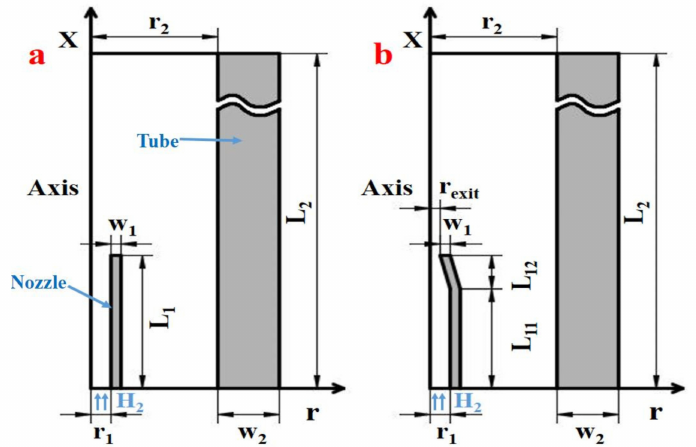
Figure 1. The schematic diagrams of physical models: ( a ) d = 0.8 mm; ( b ) d = 0.4